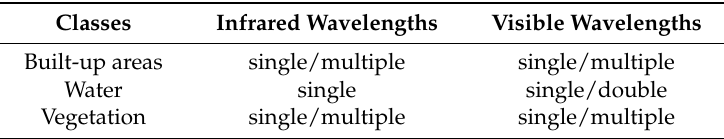
Table 2. Recorded returns from different classes at infrared and green